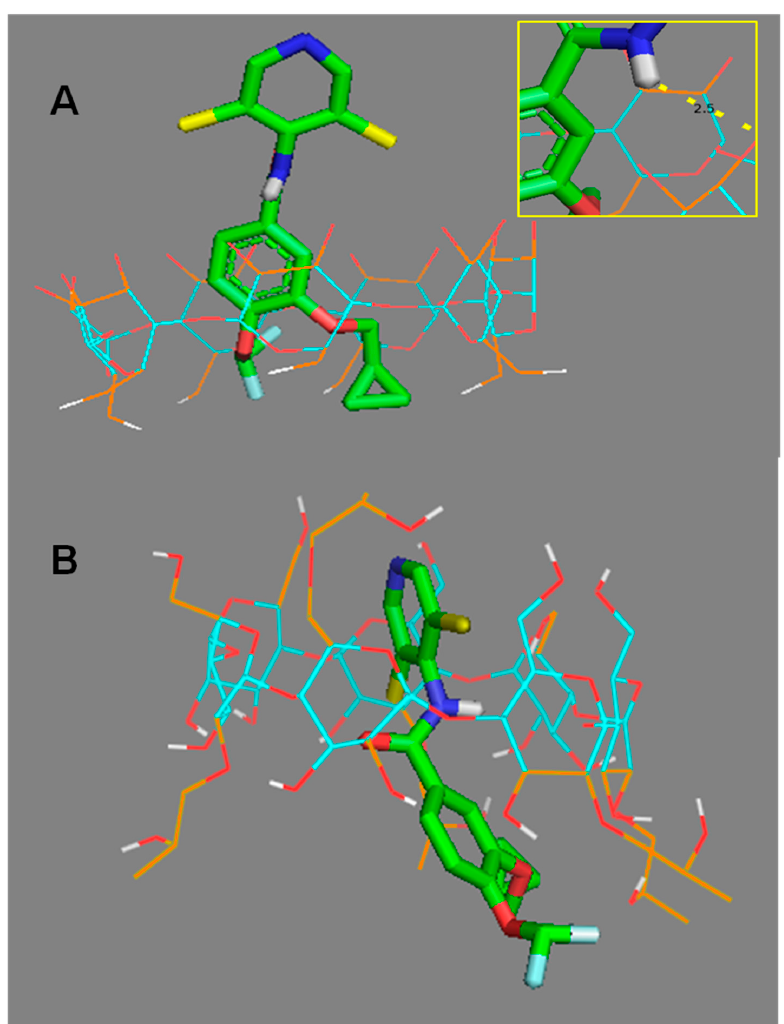
Figure 3. ( A ) Result for roflumilast/ β -CD docking pose simulation, interactions are in yellow. Flexible atoms are coloured orange. Insert . Details of interaction. ( B ) Result for roflumilast / hydroxypropyl- β -CD (HP β -CD) docking pose simulation, interactions are in yellow. Flexible atoms are coloured